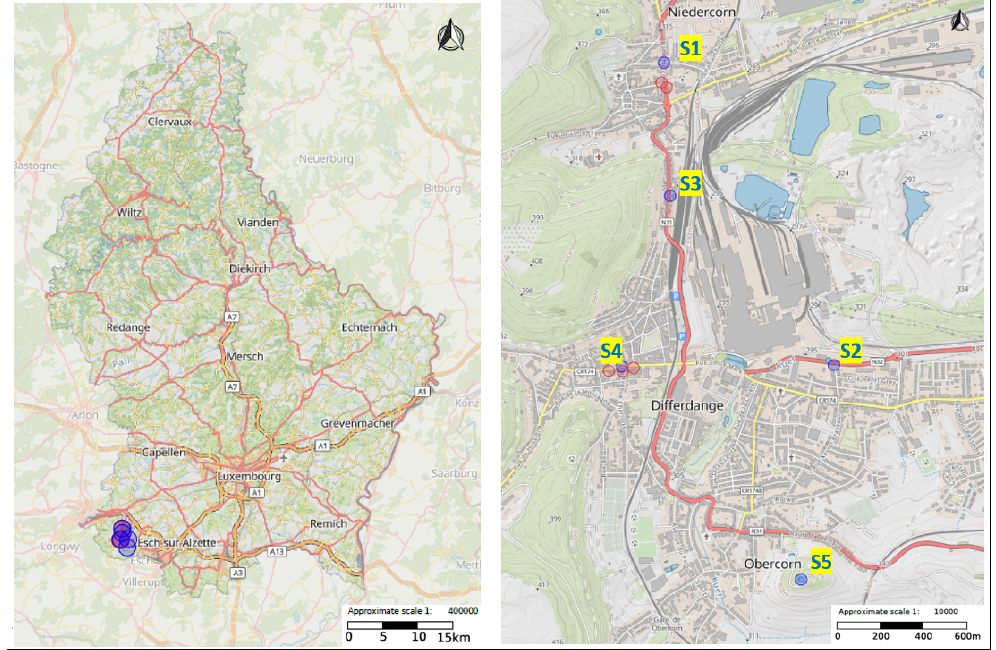
Figure 2. Location of the different sensors used in this paper: the right panel shows more precisely the location of the blue sensors (S1 to S5) for air quality measurements and the red ones for collecting traffic data. The map was generated using Luxembourg’s national official geoportal (https://www. geoportail.lu) (accessed on 11 January 2023).